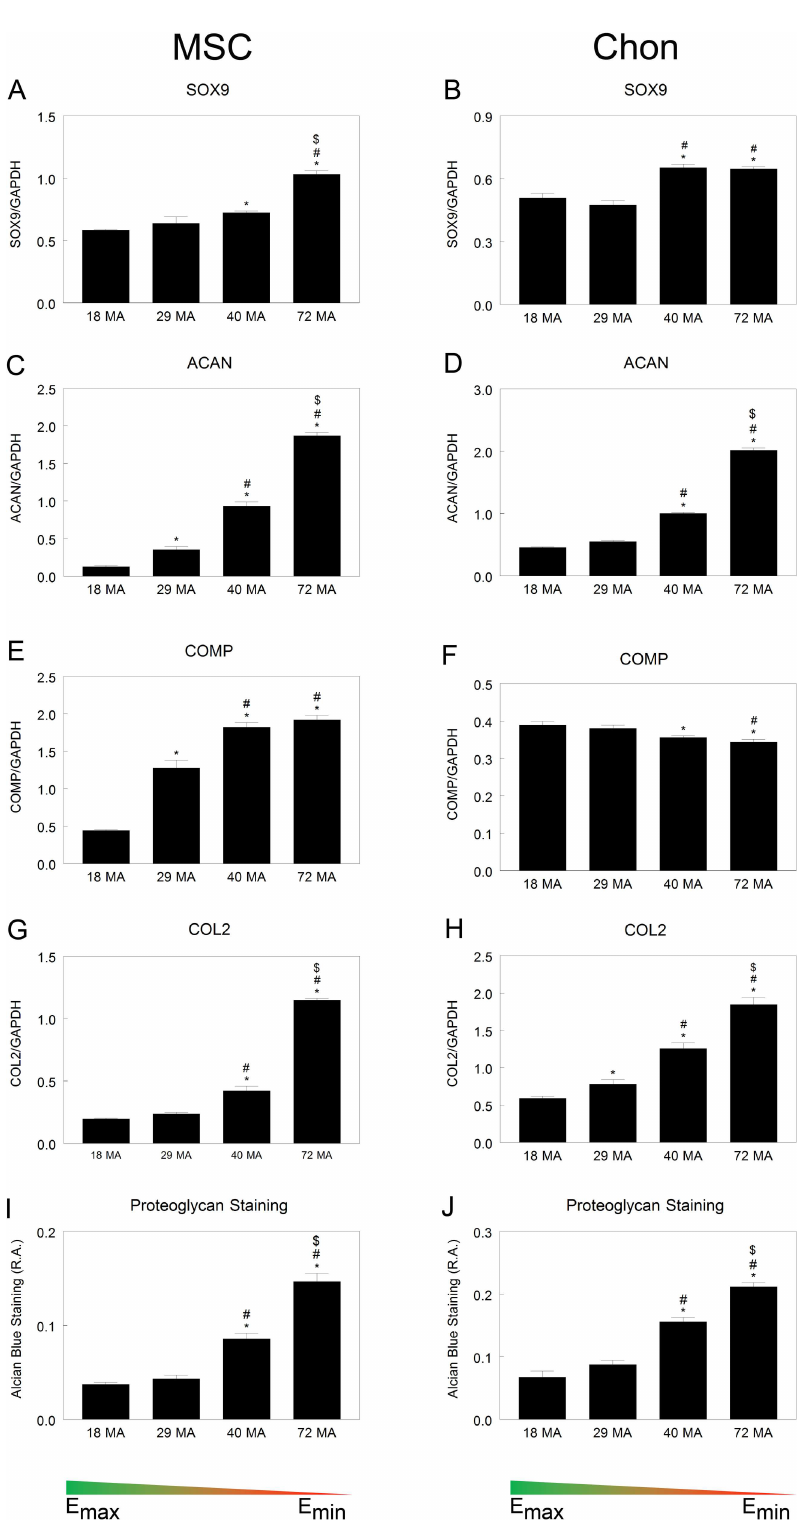
Fig 5. Chondrogenic differentiation on MA-MMA networks. Levels of chondrogenic mRNA (A-H) and quantification of proteoglycan stainingin MSCs and chondrocytes (I-J) cultured on surfaces of varying stiffness. * P < 0.05 vs. 18 MA, # P < 0.05 vs. 29 MA, $ P < 0.05 vs. 40